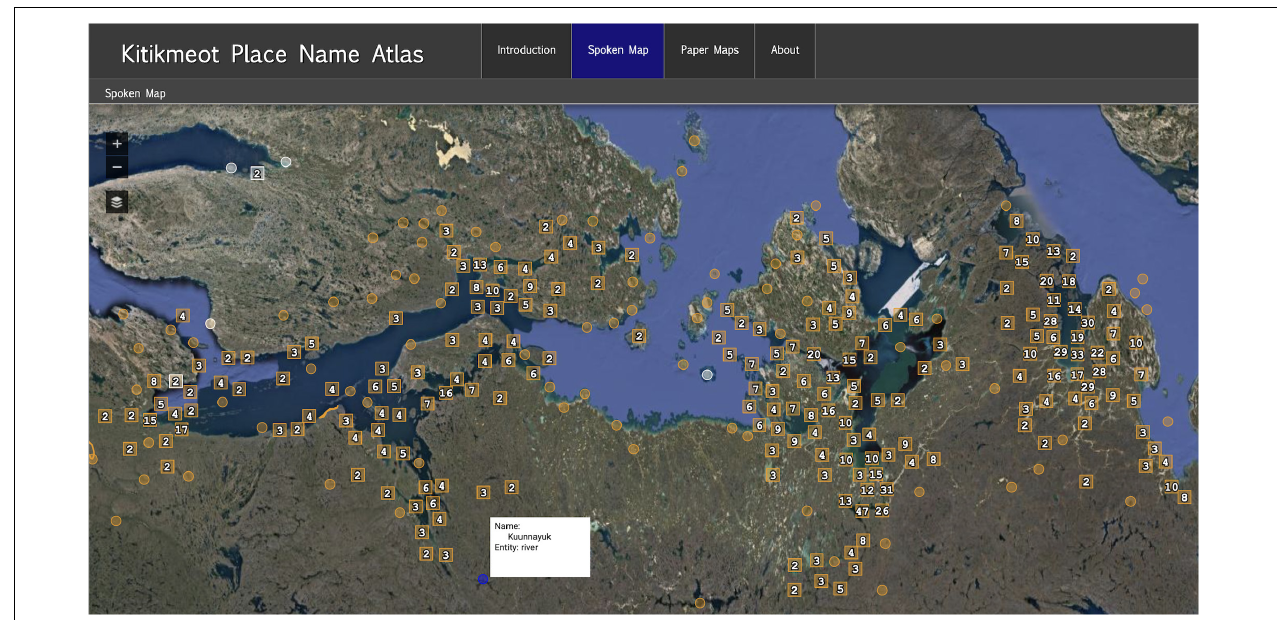
FIGURE 2 | Kitikmeot Place Name Atlas map. The map features different clusters that incorporate several points. The orange circles are individual points that include a traditional name, coordinate, a translated name, and media associated with the datapoint (if available). Screenshot from https://atlas.kitikmeotheritage.ca/index.html?module=module.names on August 10,